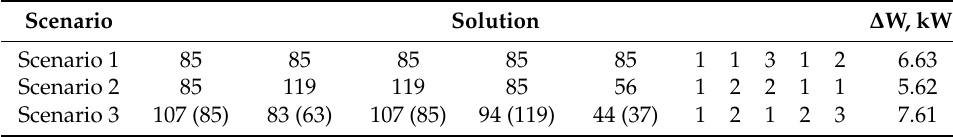
Table 2. The solutions obtained using the ESMRG algorithm.